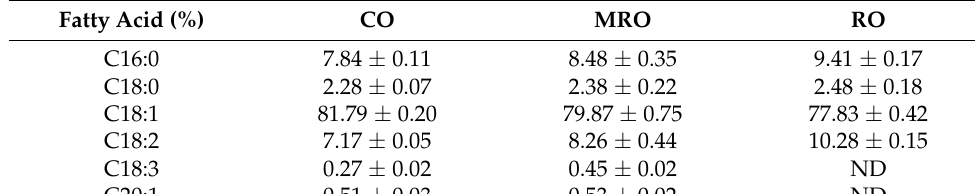
ND: not detected.